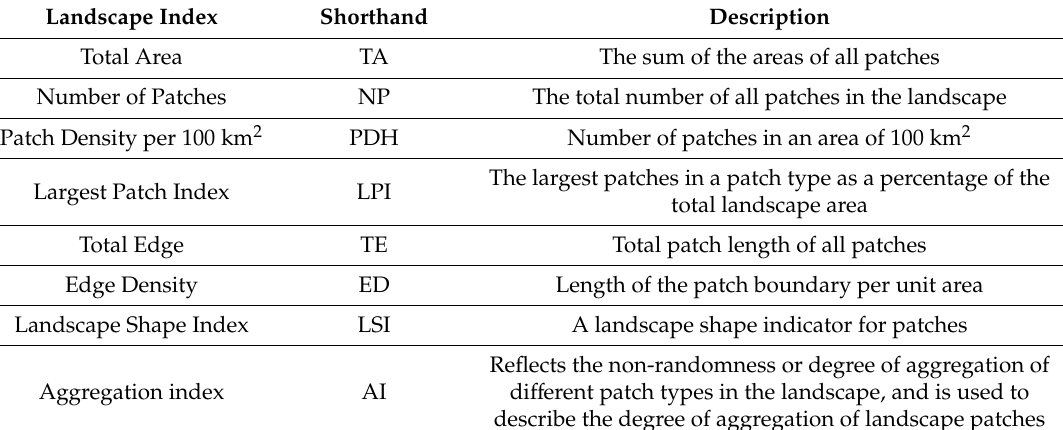
Table 1. The landscape pattern